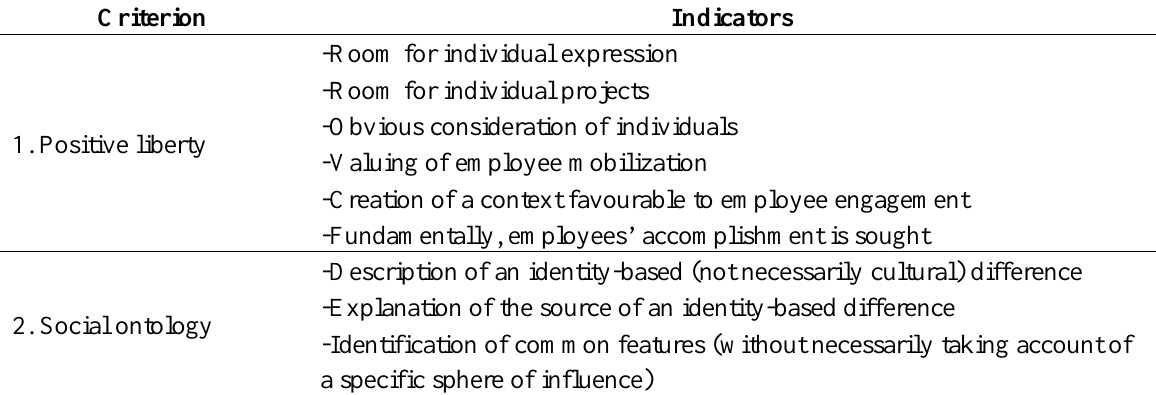
Table 2. Indicators Used in Discourse Analysis to Identify Presence of Taylorian